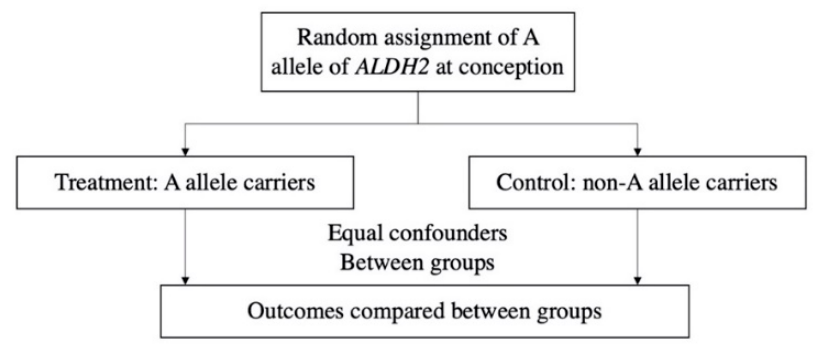
Figure 3. Design of Mendelian randomization in the current study.